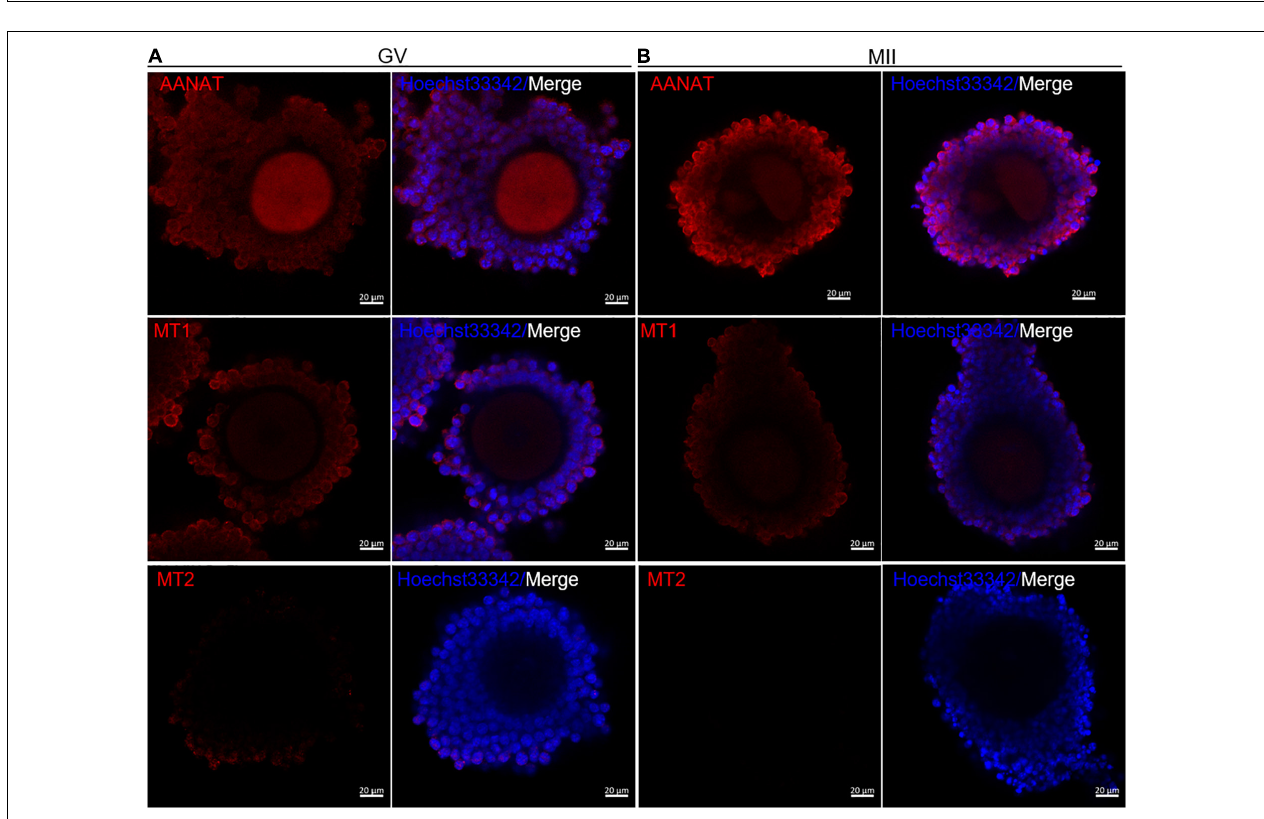
FIGURE 2 | Expression of the melatonergic system during meiotic maturation in mouse oocytes. Immunofluorescence of AANAT, MT1 and MT2 in cumulus cells and oocytes at the GV stage (A) and MII stage (B) . Bar = 20 µ m.